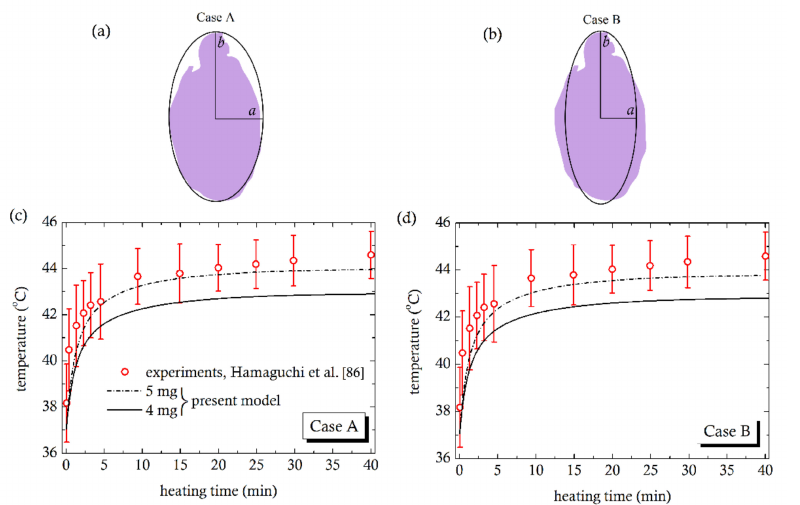
Figure 11. Two cases approximating the tumor shape from a histological cross-section by Ham- aguchi et al. [86], with a prolate spheroid. Note that the tumor histological cross-section has been redrawn from the original: ( a ) prolate spheroid shape, case A with AR ≈ 1.8, on top of the redrawn tumor and ( b ) prolate spheroid shape, case B with AR ≈ 2.2, on top of the redrawn tumor. Plots ( c , d ) show parametric comparison of the numerically determined temperature at the tumor center with the measured temperature by [86]. Temperature data points and bars are mean values and standard deviation respectively of 5 independent